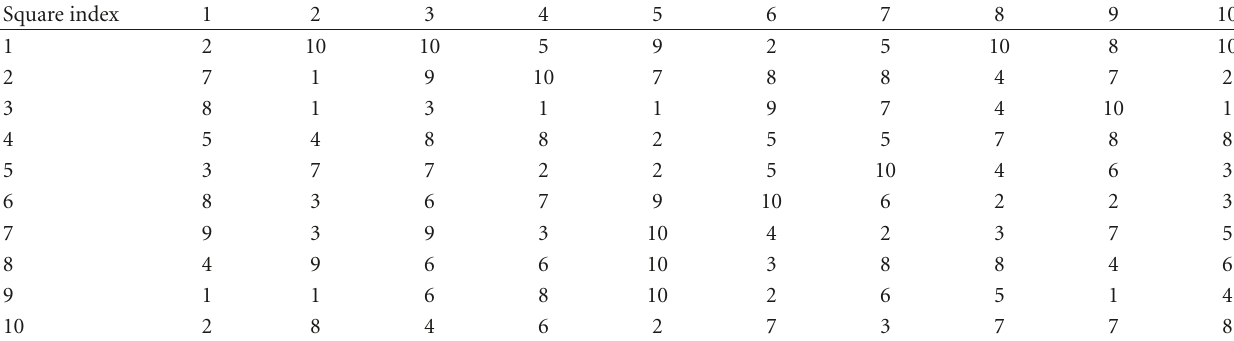
Table 1: The initial configuration of CI values of squares in disaster area. The CI values are randomly chosen between the interval [1 10]. Square